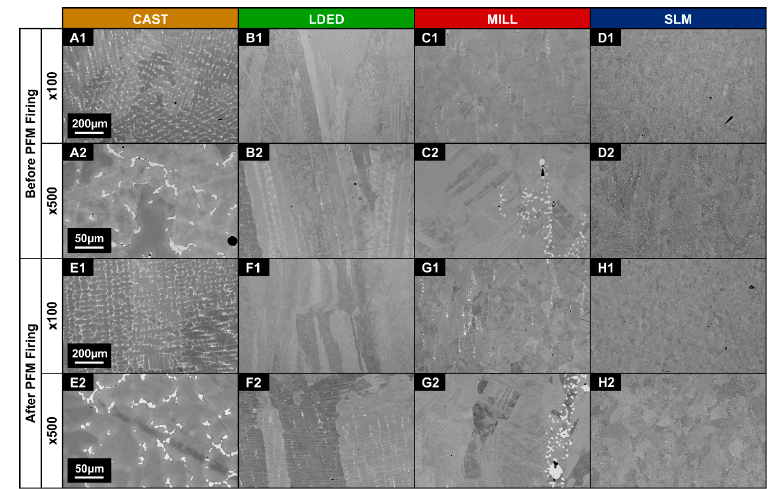
Figure 2. SEM micrographs showing a longitudinal section of each fabrication technique: CAST ( A , E ), LDED ( B , F ), MILL ( C , G ) and SLM ( D , H ); before ( A – D ) and after ( E – H ) PFM firing simulation, at ×100 ( 1 ) and ×500 ( 2 ) amplification.